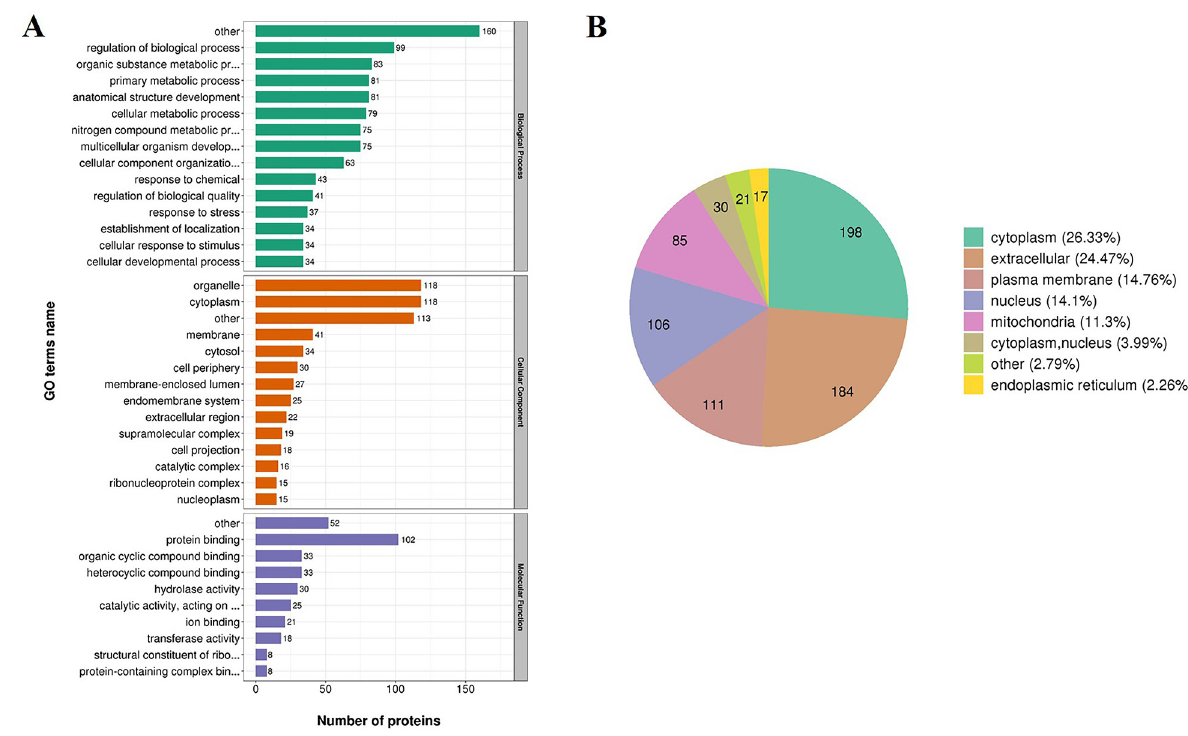
Fig 2. Bioinformatic analyses of proteins in Ts -ML-EVs. (A) Gene ontology (GO) annotation of all 753 proteins in Ts -ML-EVs. (B) Protein subcellular localization mapping of proteins.